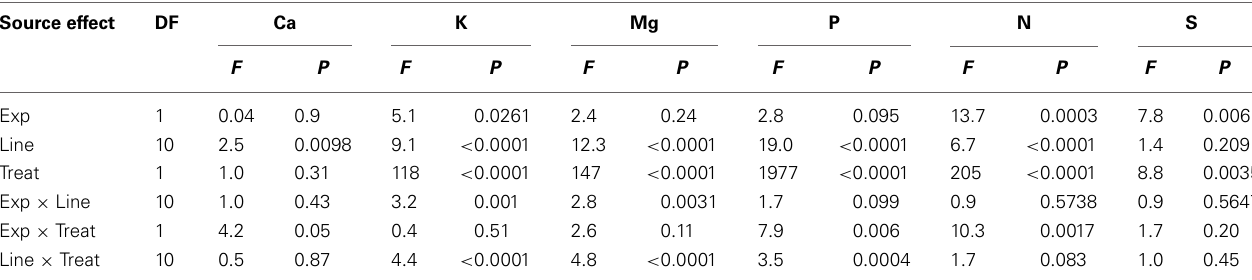
Table 1 | Analysis of variance ( F and P values) of the effects of water treatment (Treat) on cottonseed macronutrients in fuzzless and fuzzy seed cotton isogenic mutant lines (Line) in greenhouse experiments (Exp).